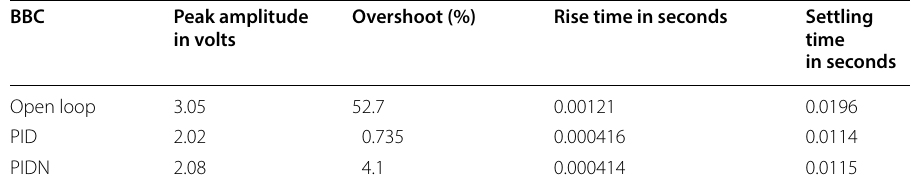
Table 2 Step response of BBC with PID, PIDN, and without PID in boost mode